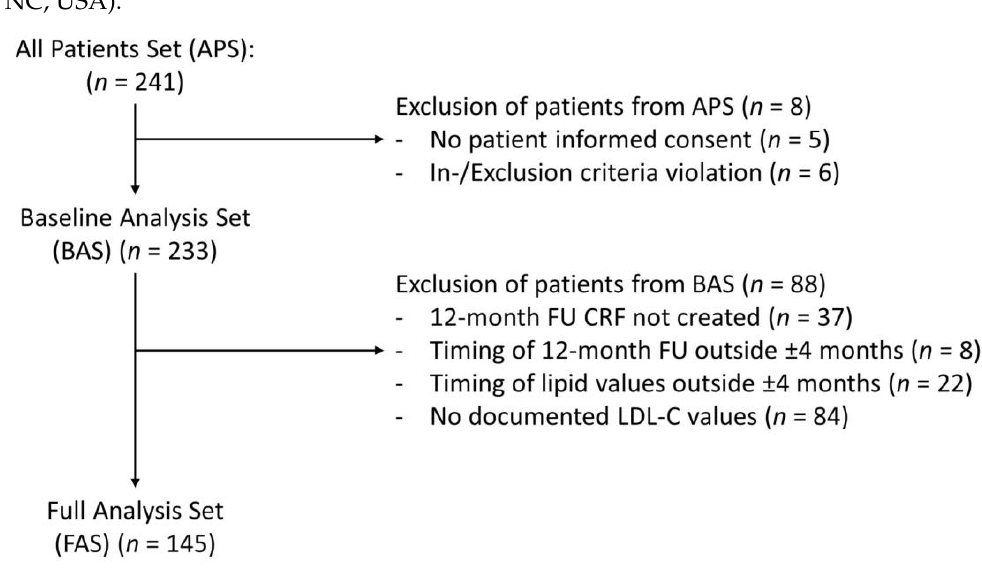
Figure 1. Patient flow. APS, all patients set; BAS, baseline analysis set; FAS, full analysis set; CRF, case report form; FU, follow-up; LDL-C, low density lipoprotein cholesterol.